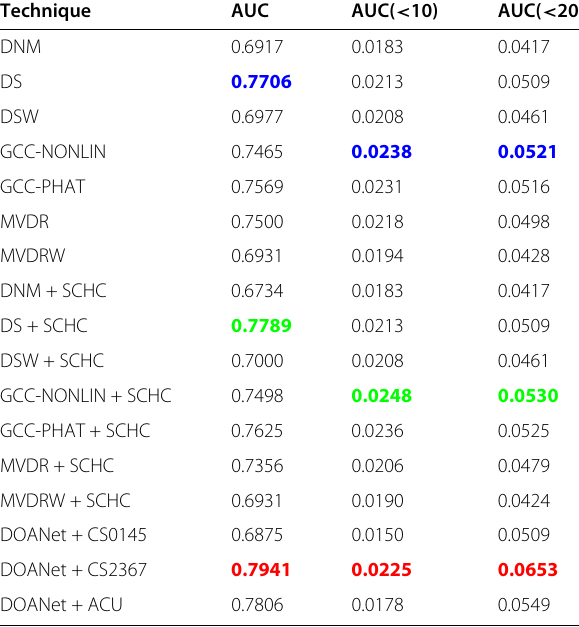
Table 4 AUC of static azimuth angle deviation